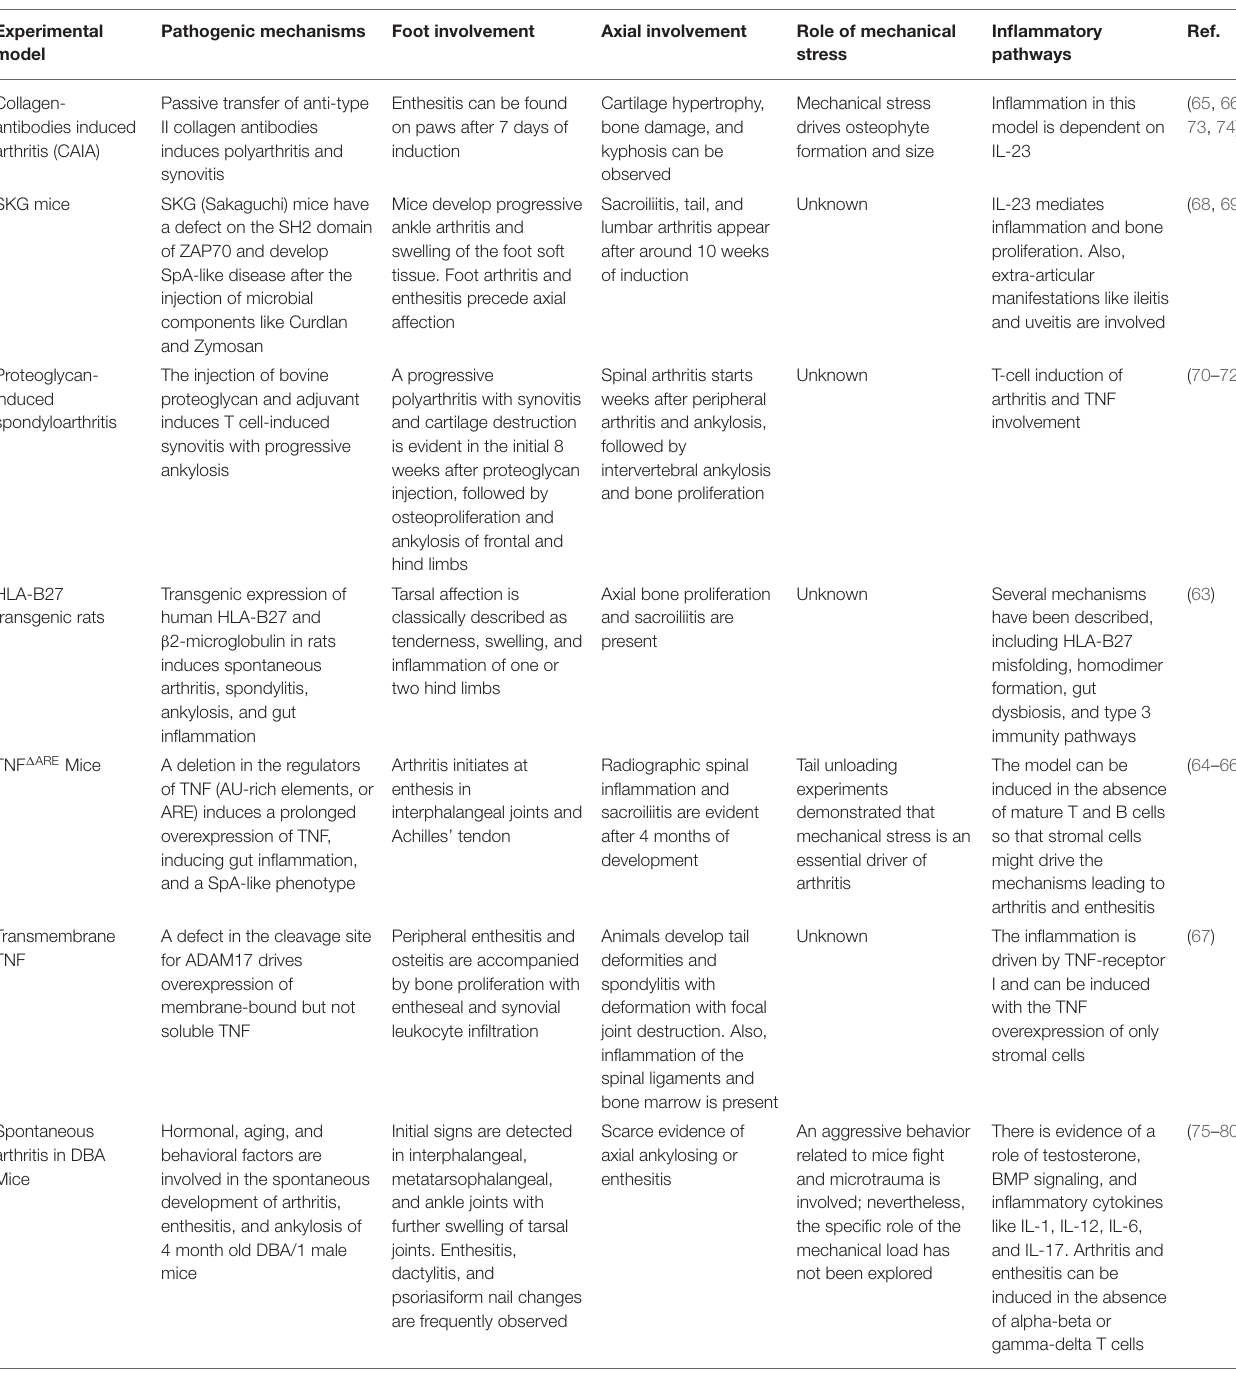
TABLE 1 | Foot and axial involvement in animal models of SpA. Experimental